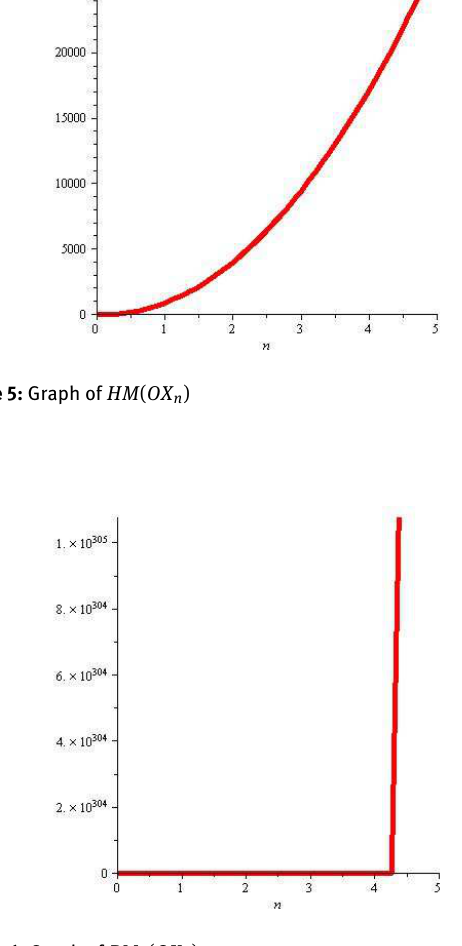
Figure 6: Graph of PM 1 ( OX n )